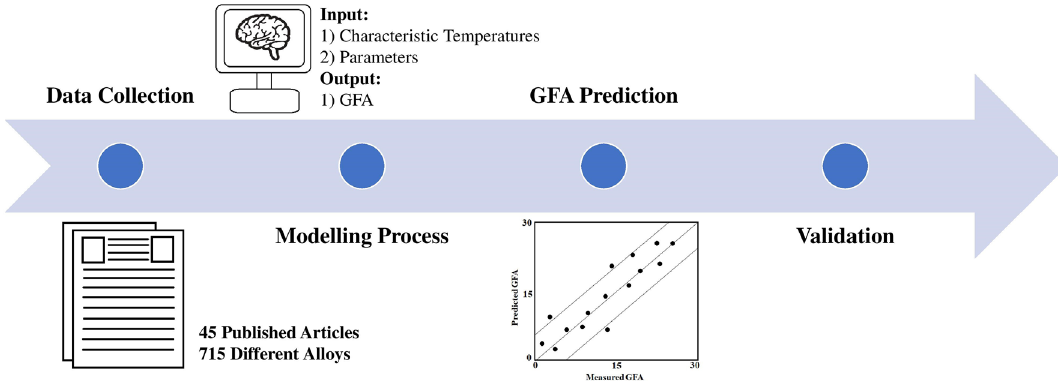
Figure 1. Schematic demonstration of steps involved in the process of ML